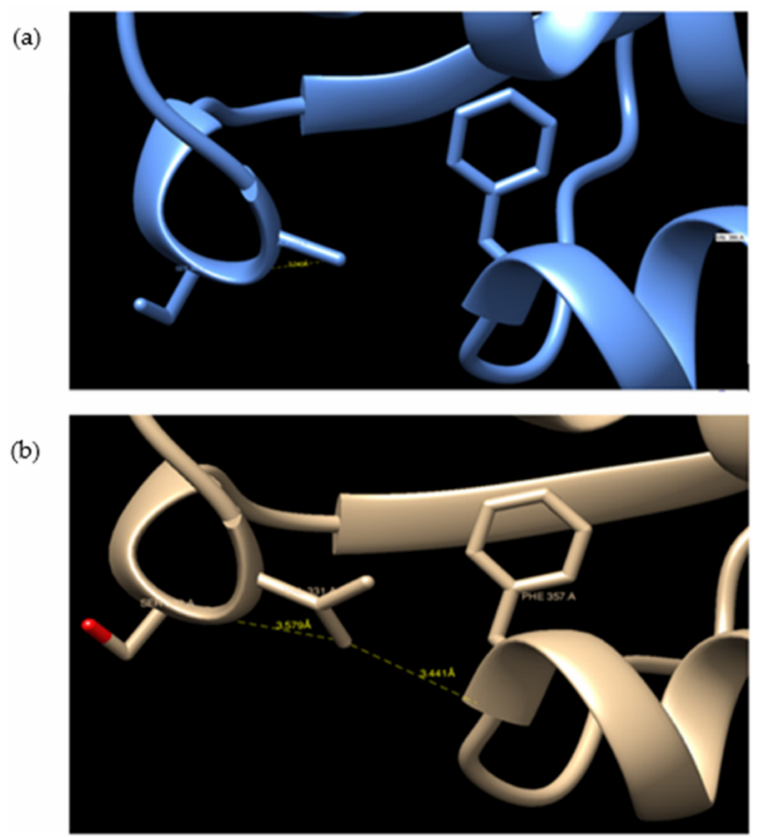
Figure 5. Substitution of valine for alanine in the N-terminal ATP-binding domain at position 364: ( a ) GaHSP70-2 and ( b ) DnaK. The substitution of valine for alanine hindered the aromatic interaction between valine at 364 and phenylalanine at position 357. The structures were visualized using CHIMERA UCSF